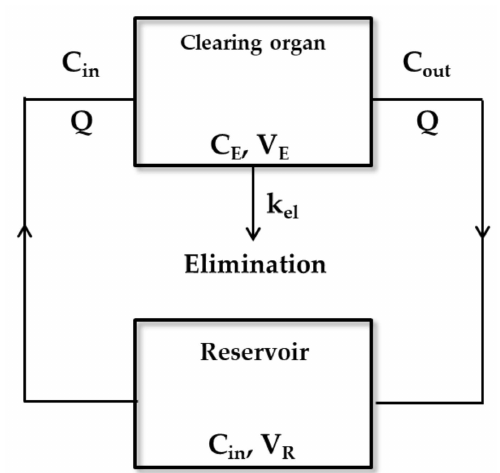
Figure 1. The perfusion model including one reservoir and one clearing organ. In this model, Q refers to the rate of perfusate or blood flow. C in is the drug concentration in the artery entering the reservoir and clearing organ. C out denotes the drug concentration in veins leaving the clearing organ and entering the reservoir, which is a non-clearing organ. V E and V R indicate the volume of clearing organ and reservoir, respectively. The elimination process is followed by first-order kinetics and its elimination constant is represented by k el . C E is the drug concentration in the clearing